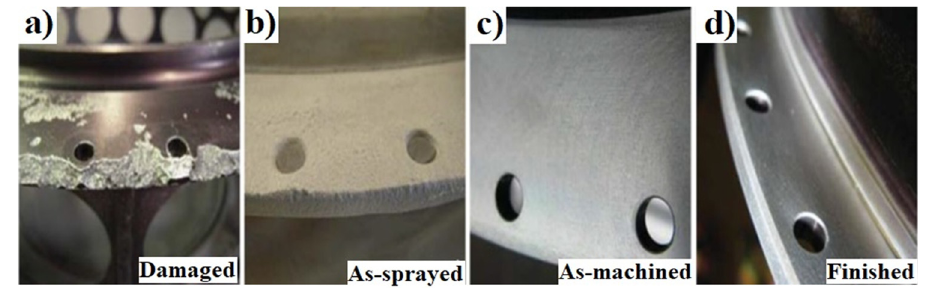
Figure 16: Repairing steps for CSAM [ 66 ] .